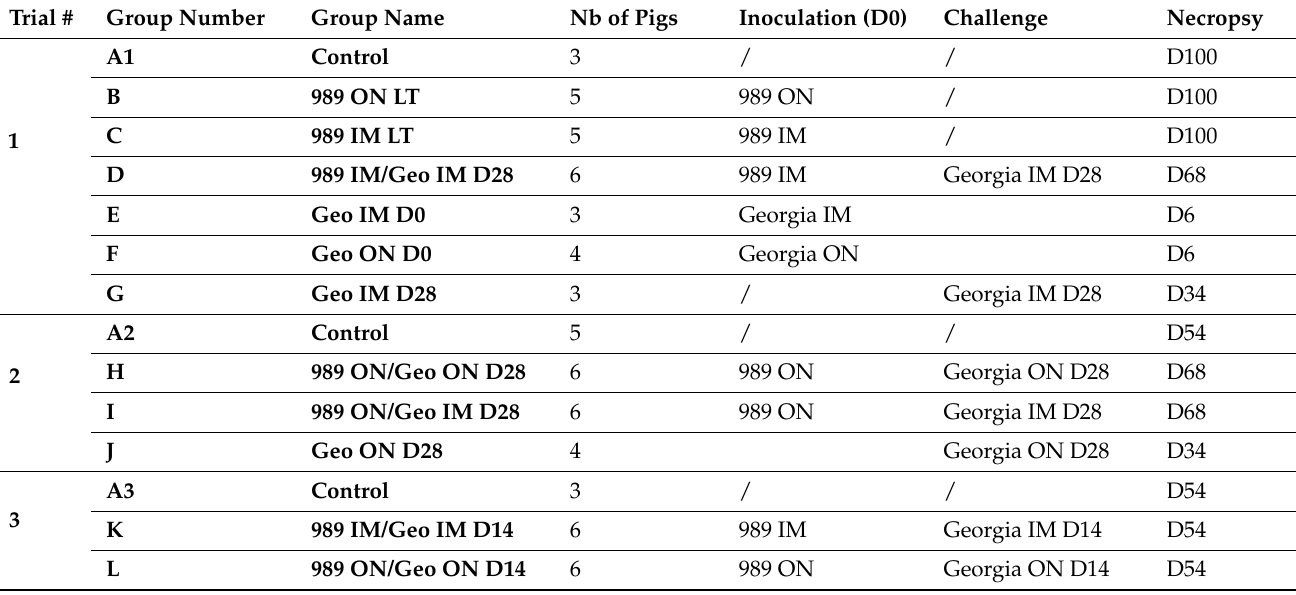
Table 1. Experimental design for the in vivo